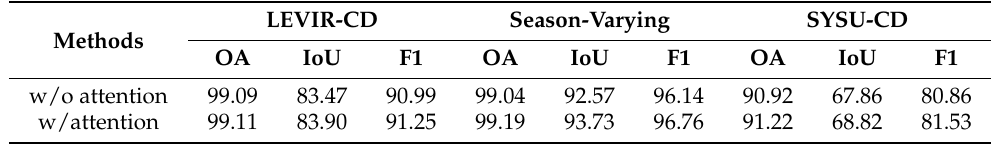
Table 9. Effects of attention